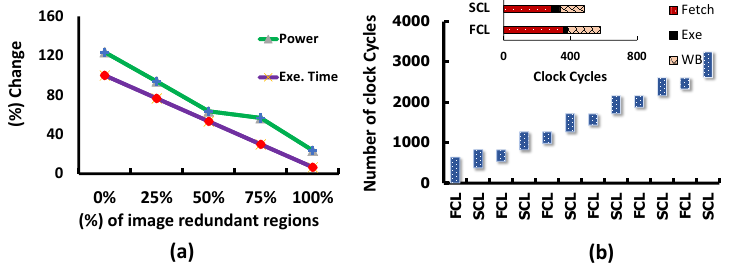
Figure 11. ( a ) Percentage change of power and time with image relevance ( b ) Pipeline processing system for image convolution for one image patch. (Inscribed: Time required to fetch, Exe and WB for different modules).